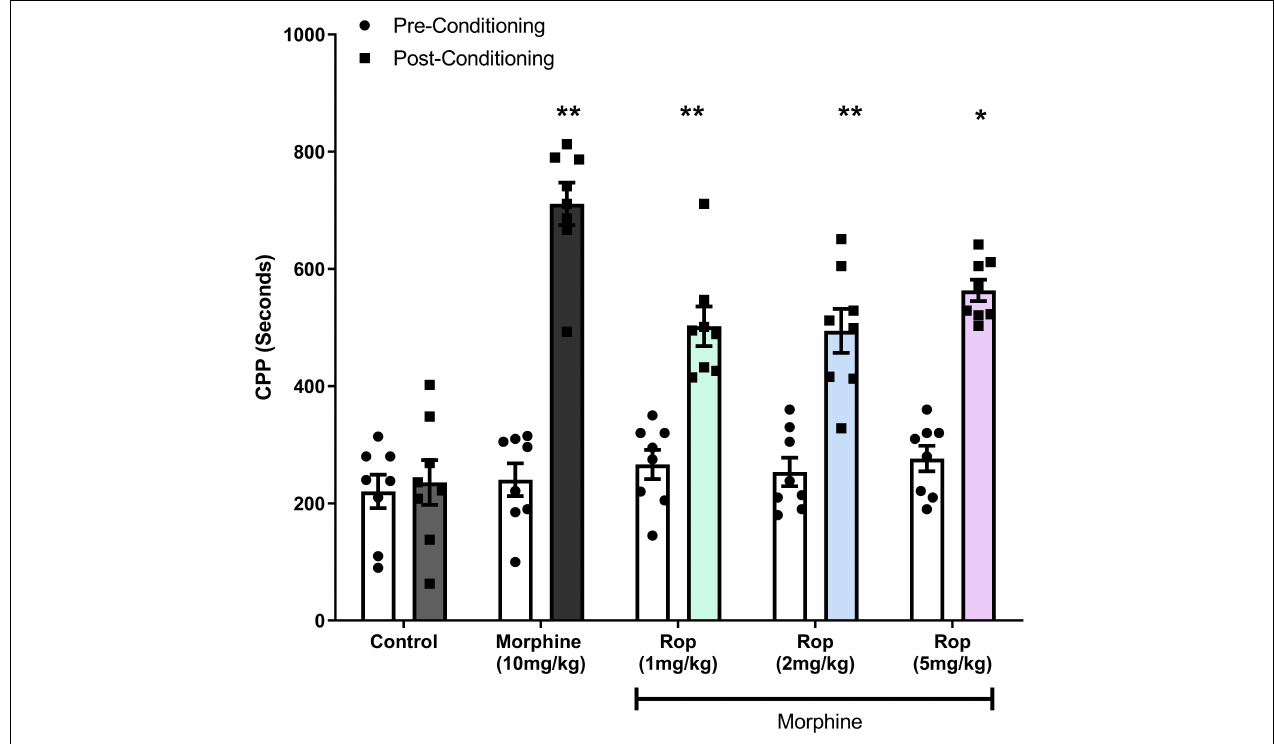
FIGURE 3 | Effect of combination treatment on morphine-induced CPP (combinations: 1, 2, and 5 mg/kg Rop plus 10 mg/kg morphine). Data expressed as mean ± SD ( n = 8). ** p < 0.01, * p < 0.05 relative to the preconditioning group; Tukey test.